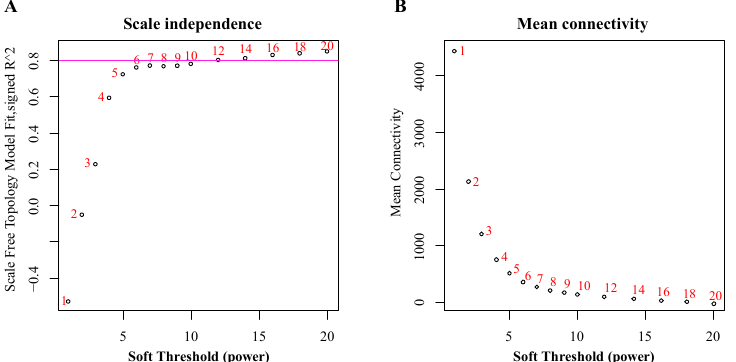
Figure 2. Soft threshold determination of gene co-expression network. ( A ) Analysis of the scale-free topology model fit index for various soft thresholds. ( B ) Analysis of the mean connectivity for various soft thresholds. Numbers adjacent to the spots are power values.